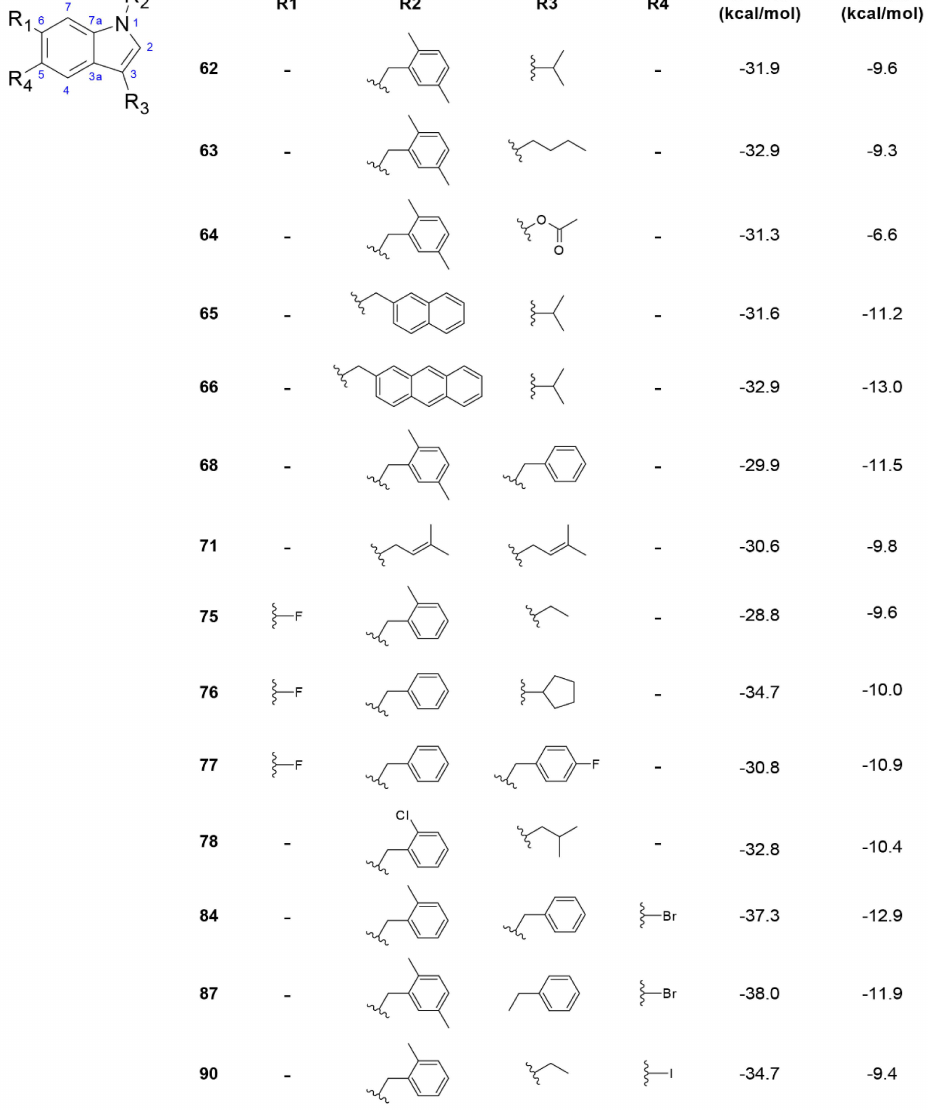
Figure 5. Compounds from L3 library with the most favorable energy scores. The compounds were selected according to the cut-off values defined in Section